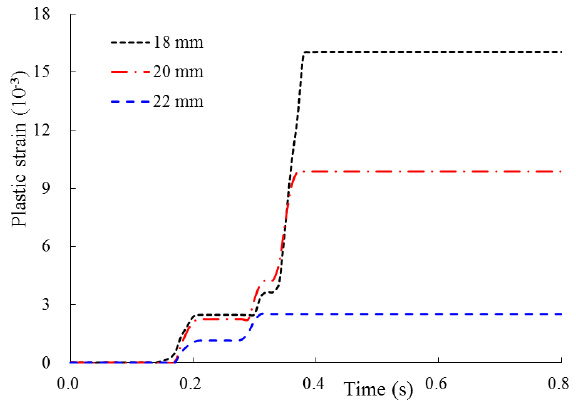
Figure 18. Max plastic strain time-history of steel plate.